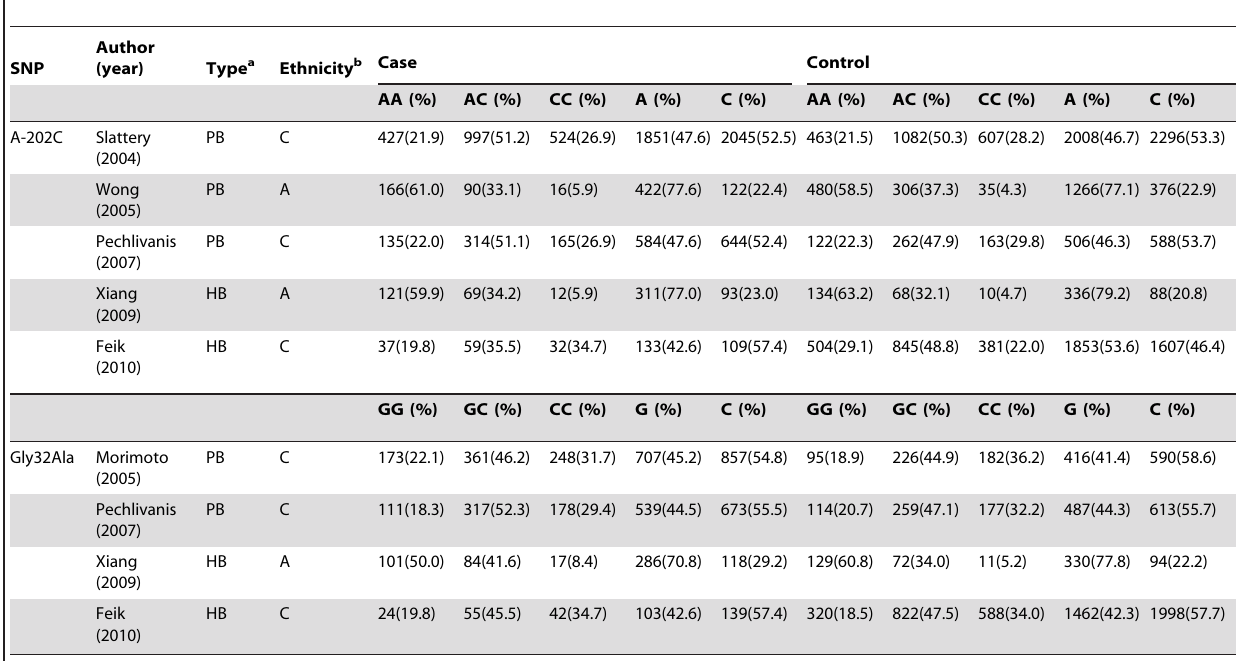
Table 1. Distribution of genotypes and alleles of IGFBP3 A-202C and Gly32Ala polymorphisms among cases and controls.